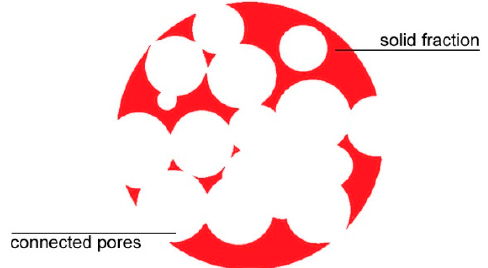
Figure 1. Cross-section of a sample with reduced solid fraction due to connected pores.